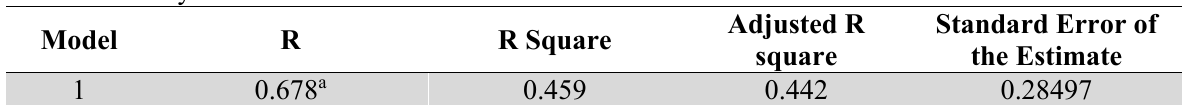
Model summary for UTAUT framework and financial